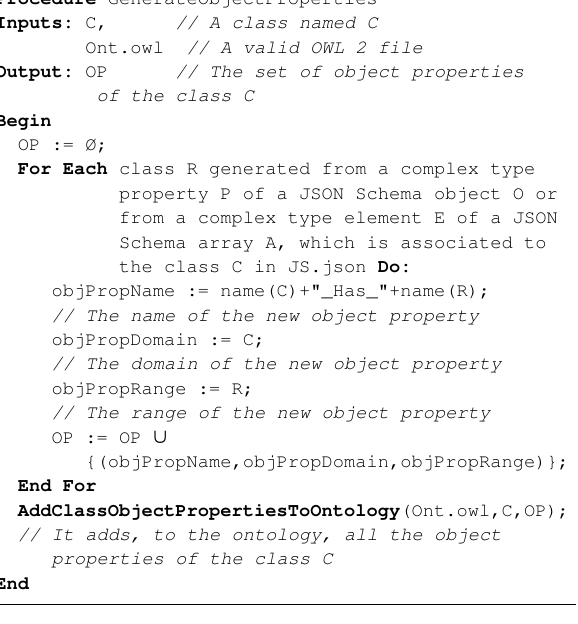
Fig. 5 Algorithm of the “GenerateObjectProperties” procedure.